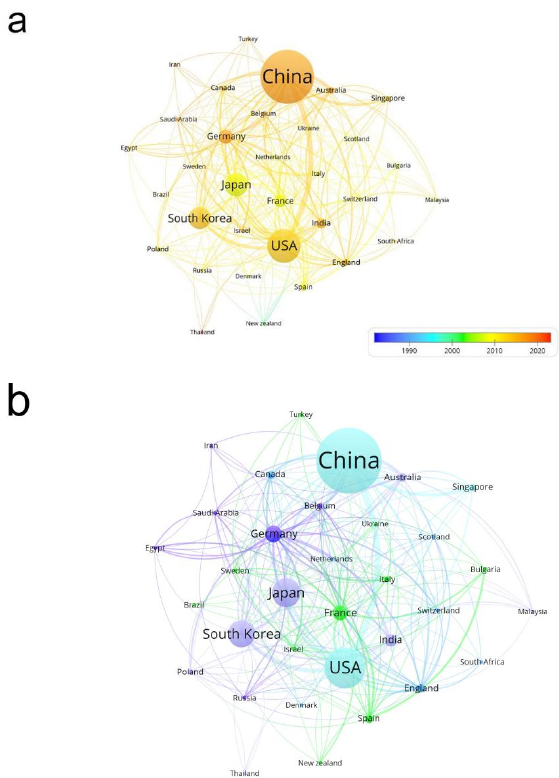
Figure 2. Country clustering and analysis of international co-operation patterns: ( a ) country co- operation relationships and ( b ) country clustering analysis.